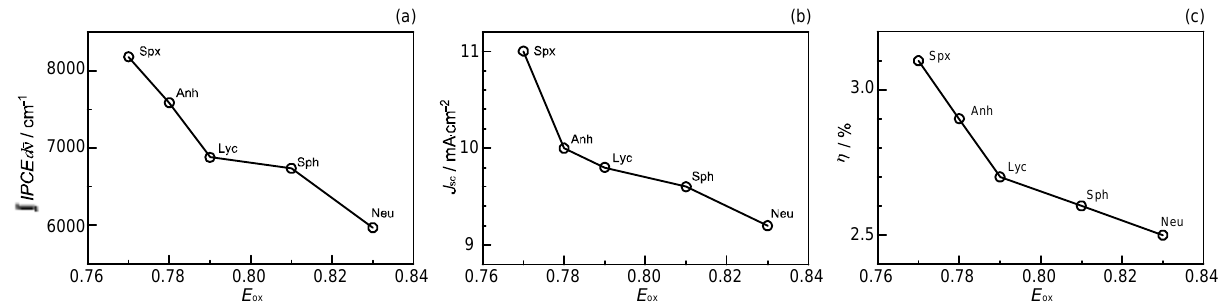
electron injection to TiO , are listed in Table 4; they have been determined by the SVD and global- 2 fitting analysis of the data matrices in the 0.00–0.50 ps time region. Figure 20. Dependence of the integrated IPCE ( d IPCE ν ∫ ), photocurrent ( J conversion efficiency ( η ) on the one-electron oxidation potential ( E the Phe a -sensitized solar cells.